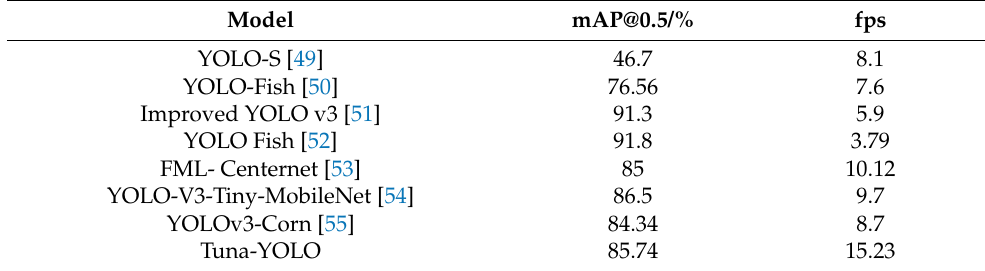
Table 8. Comparison with different algorithms based on the